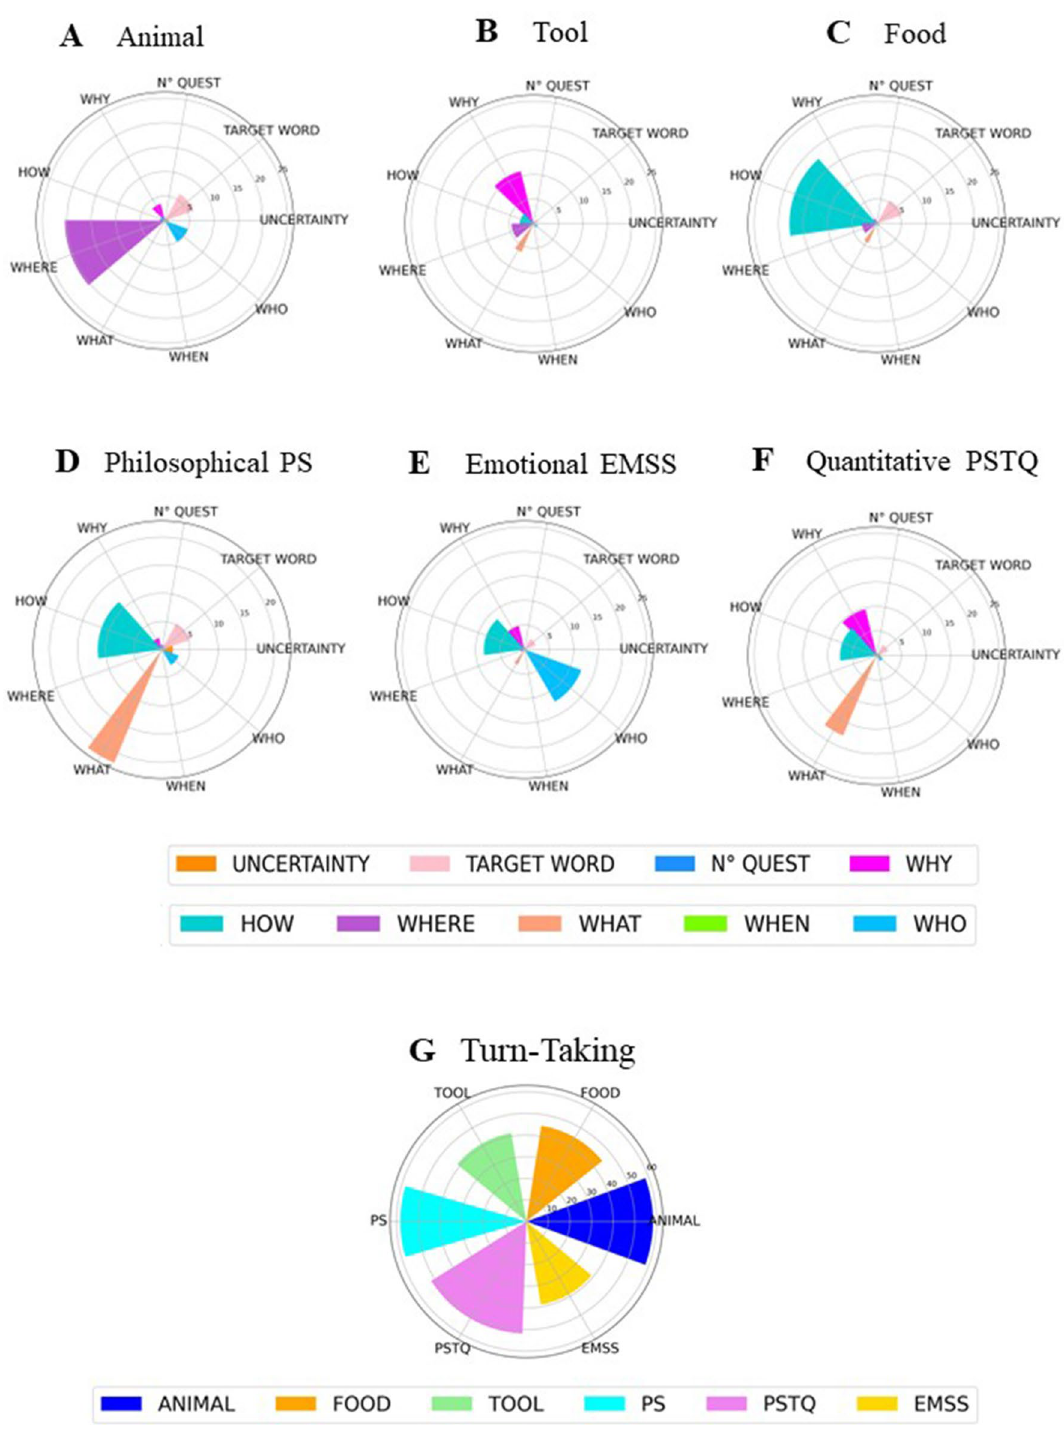
Figure 1. Polar plots for sentences including animals ( A ), tools ( B ), food ( C ), PS, philosophical-spiritual ( D ), EMSS, emotional-social ( E ), and PSTQ, physical-spatio-temporal-quantitative ( F ) concepts, showing the row frequency count of the variable number of questions (dodger blue), the percentage of the other coded variables concerning conversation i.e., uncertainty expressions (dark orange), target word repetition (pink), why (magenta), how (dark turquoise), where (medium orchid), who (deep sky blue), when (lawn green), and what (light salmon) questions. A polar plot showing the percentage of the turn-taking variable ( G ) for sentences including animals (blue), tools (light green), food (orange), PS, philosophical-spiritual (aqua), EMSS, emotional-social (gold), PSTQ, physical-spatio-temporal-quantitative (violet)